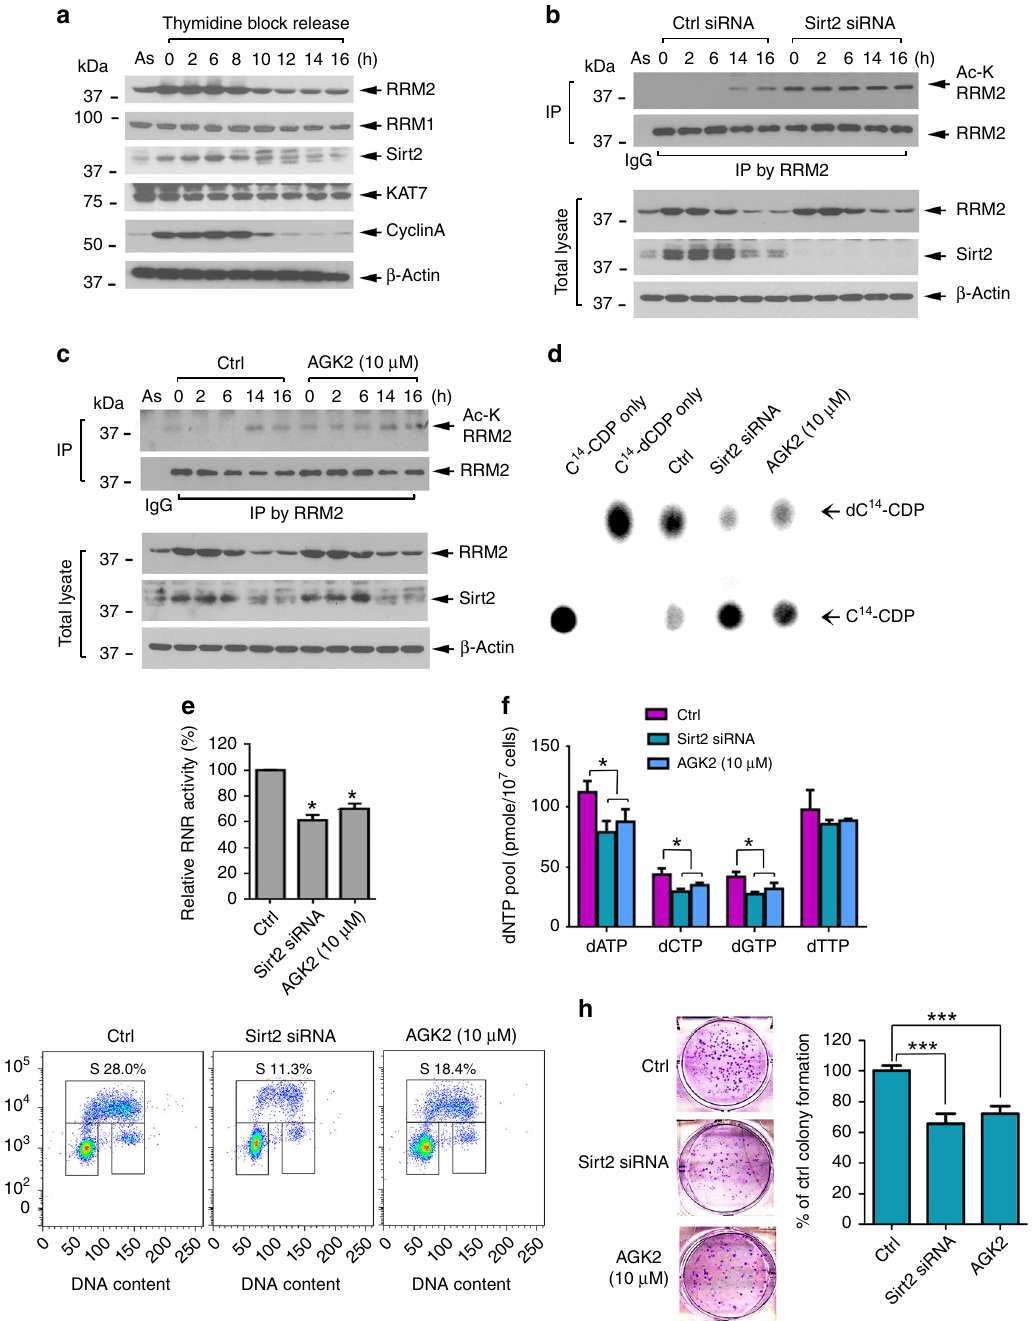
Fig. 5 Sirt2 deacetylates RRM2 in a cell-cycle-dependent manner. a H1299 cells were synchronized at the G1/S boundary by double-thymidine block and then released into normal culture medium. RRM1, RRM2, Sirt2, KAT7, and cyclin A were analyzed by western blot at various time points. As asynchronous. b , c H1299 cells were transfected with Ctrl or Sirt2 siRNA or treated with Sirt2 inhibitor AGK2, followed by synchronization, cell cycling, and analysis of RRM2 acetylation as above. d , e H1299 cells were treated with Sirt2 siRNA or Sirt2 inhibitor (AGK2), followed by analysis of RNA activity. The error bars indicate ± s.d. of three separate experiments. * P <0.05, by two-tailed t test. f H1299 cells were transfected with Ctrl or Sirt2 siRNA or treated with Sirt2 inhibitor AGK2, followed by measurement of dNTP levels. The error bars indicate ± s.d. of three separate experiments. * P <0.05, by two-tailed t test. g , h H1299 cells were transfected with Sirt2 siRNA or treated with Sirt2 inhibitor AGK2, followed by analysis of cell proliferation and cell-cycle distribution using BrdU/7-AAD staining or colony-formation assay. The error bars indicate ± s.d. of three separate experiments. *** P <0.001, by two-tailed t test levels for DNA repair 8,46,47 . To test whether DNA damage reg- (Fig. 6a, upper panel). Intriguingly, IR and CPT exposure also ulates RRM2 acetylation/deacetylation, H1299 cells were treated slightly enhanced RRM2 protein expression, but had no effect on with ionizing radiation (IR) or camptothecin (CPT), followed by KAT7 and Sirt2 protein levels (Fig. 6a, lower panel). Mechan- analysis of RRM2 acetylation. A signi fi cant decrease in RRM2 istically, IR and CPT promoted an interaction between Sirt2 and acetylation was observed following DNA damage by either agent RRM2 (Fig. 6b), but did not in fl uence RRM2/KAT7 association NATURE COMMUNICATIONS| (2019) 10:3213